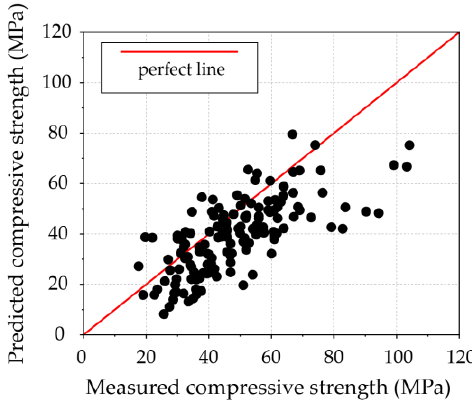
Figure 6. Performance of the empirical model using the training set.